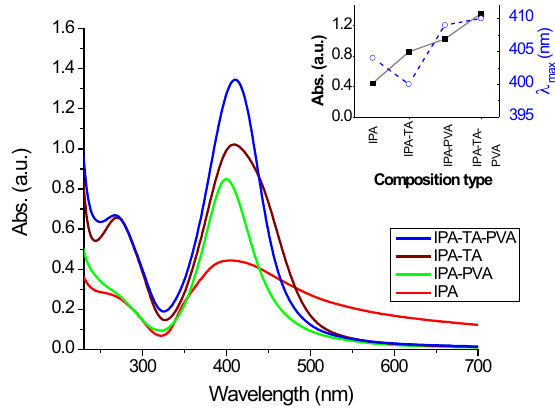
Figure 8. The UV-VIS spectra for the samples obtained by irradiation at low dose rate and different reaction compositions, irradiation dose 2 kGy, pH=5. Inset: the effect of composition type on the absorption peak characteristics.